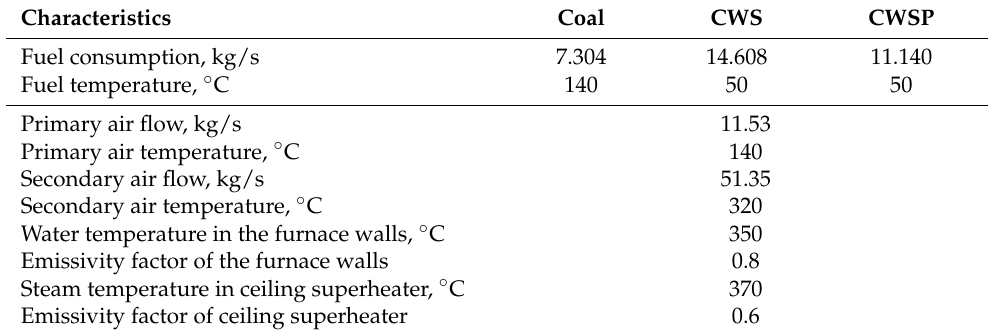
Table 3. Boundary conditions.